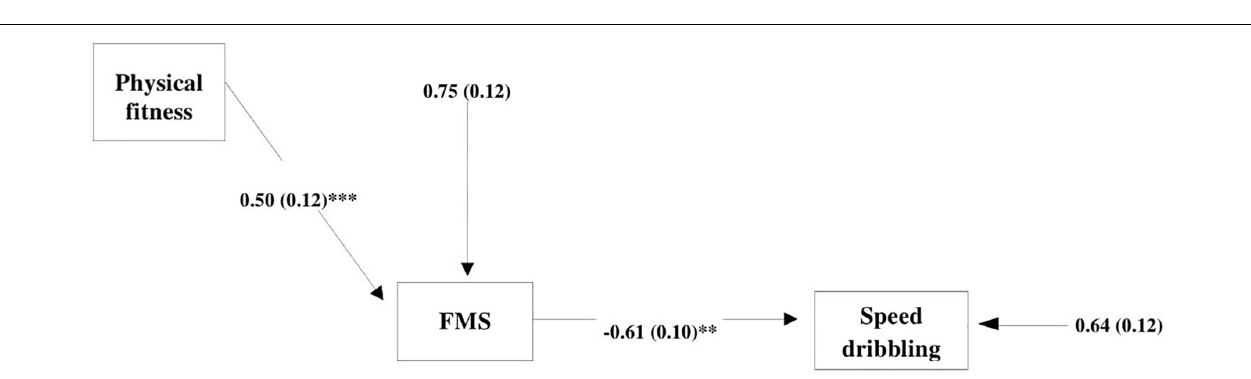
FIGURE 3 | Second path analysis model with only the indirect effect of physical fitness on speed dribbling with FMS as the mediator variable [Satorra–Bentler χ 2 ( df = 1) = 1.3; p = 0.254; RMSEA = 0.08; SRMR = 0.04; CFI = 0.99; TLI = 0.97]; FMS, fundamental motor skills. ∗∗ p < 0.01; ∗∗∗ p <